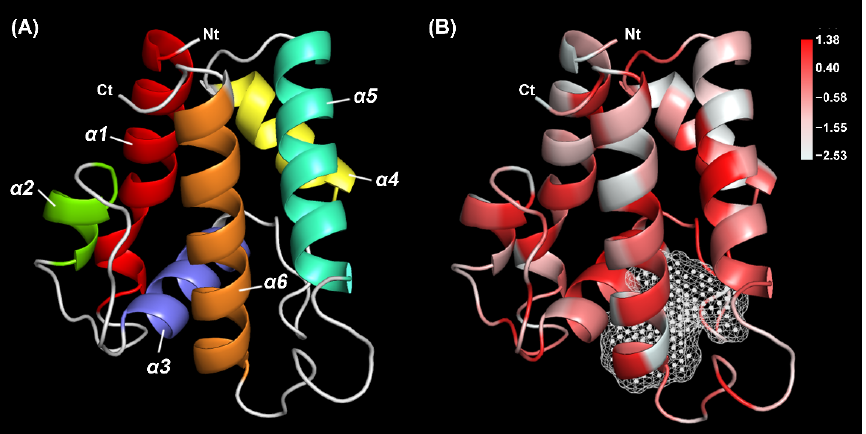
Figure 3. Three-dimensional structure model of TrufOBP4. ( A ) The 3D structures of TrufOBP4 with six helices labeled and colored by the rainbow. ( B ) The hydrophobic profiles and predicted binding pocket of TrufOBP4. The levels of hydrophobic value were illustrated by a gradient color scale, and the binding pocket was marked by white dots. Nt: N-terminus, Ct: C-terminus.